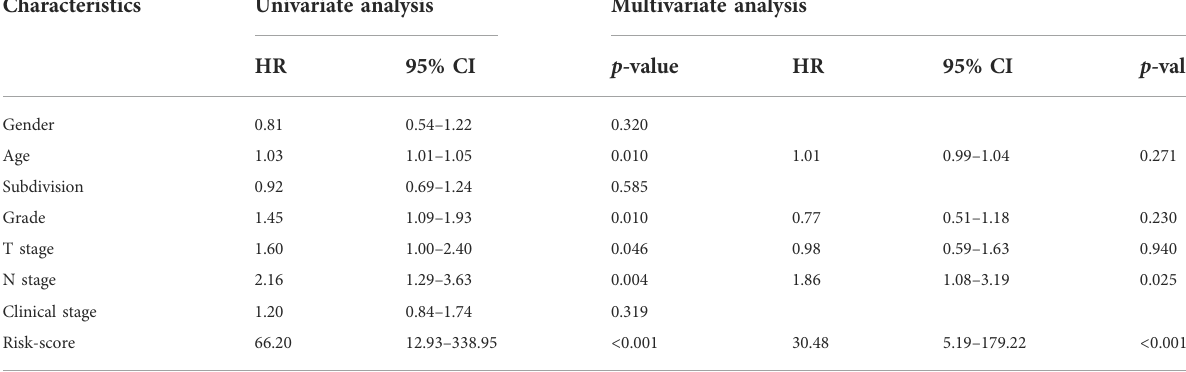
TABLE 2 Univariate and multivariate analysis of survival factors in patients with PaCa.